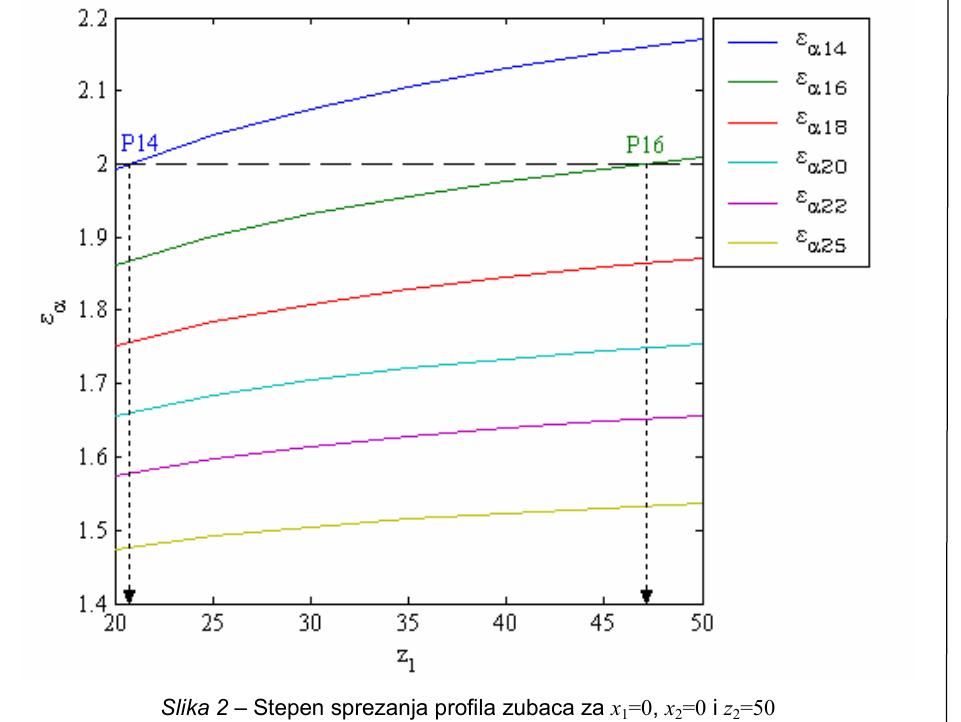
Figure 2 – Transverse contact ratio for x 1 =0 , x 2 =0 and z 2